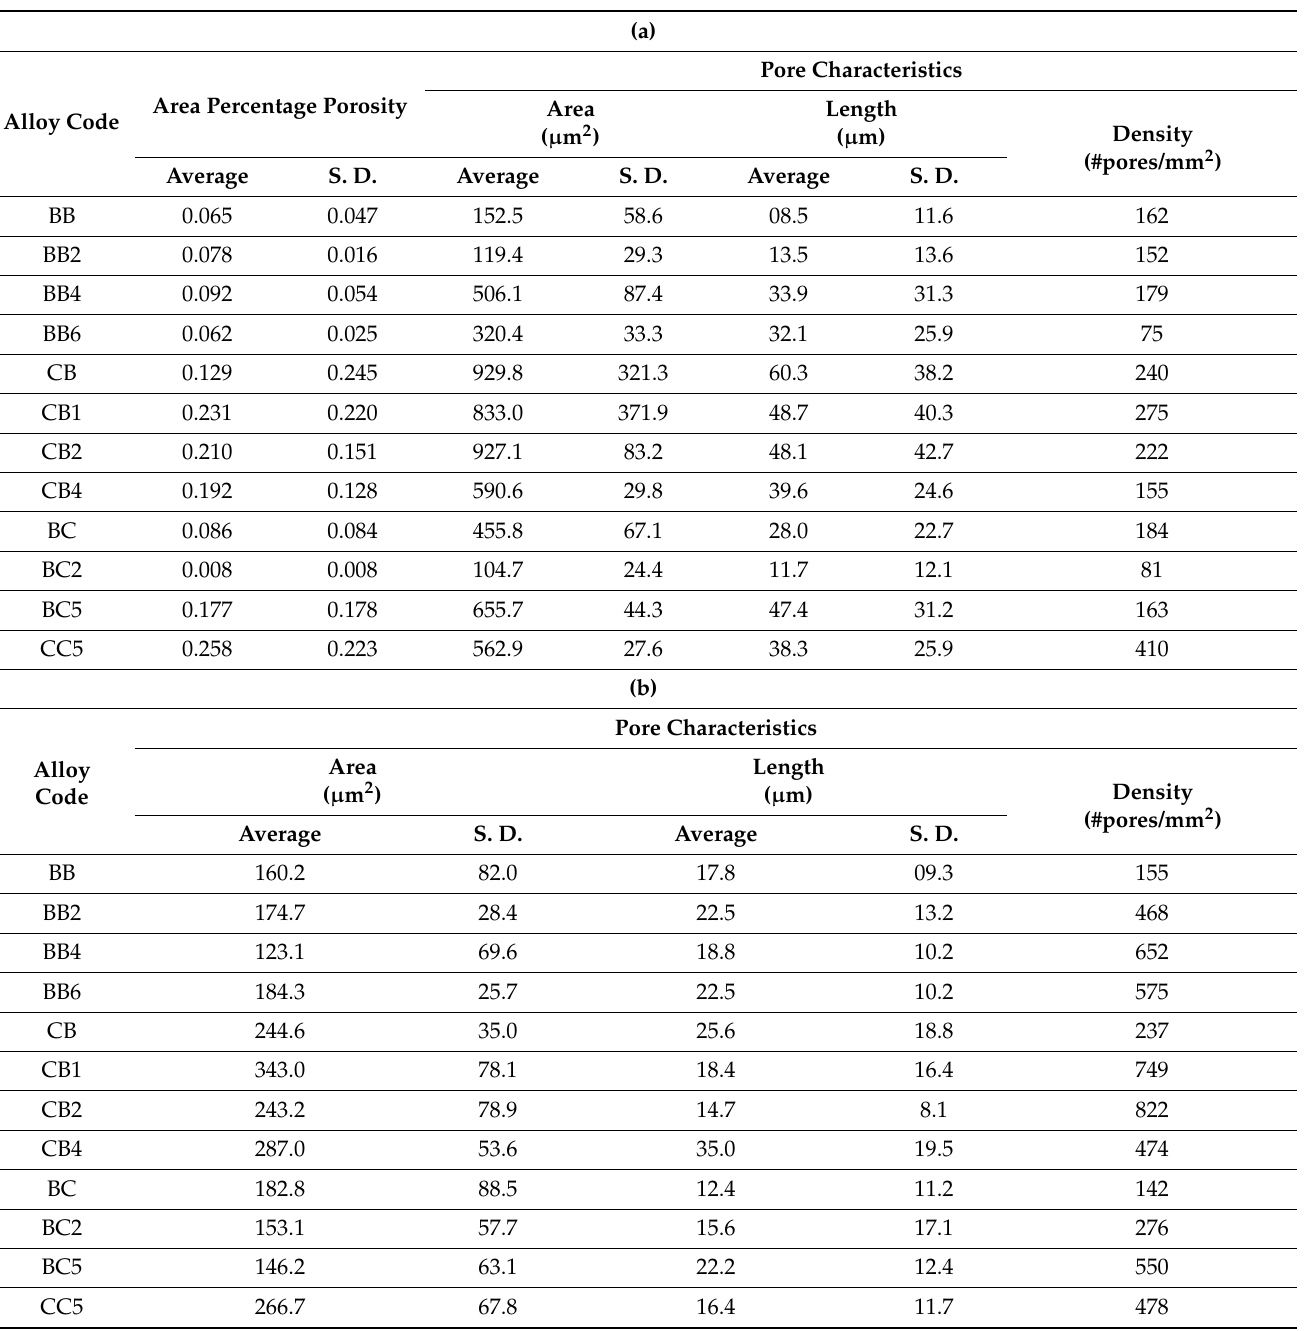
Table 3. (a) Porosity characteristics of Sr-modified alloys—variable angle mold (small). (b) Porosity characteristics of Sr-modified alloys—variable angle mold (15 ◦